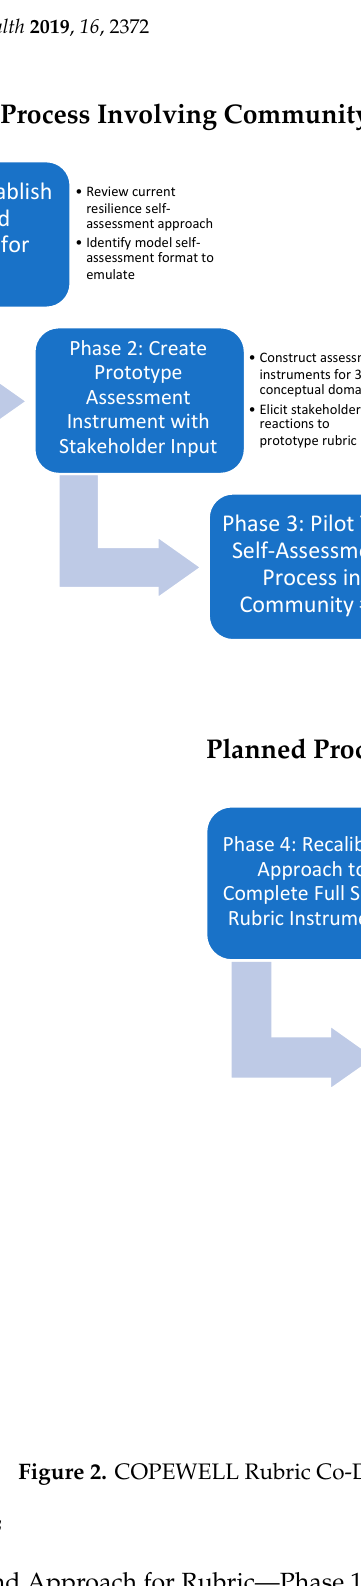
Figure 2. COPEWELL Rubric Co-Development Process.